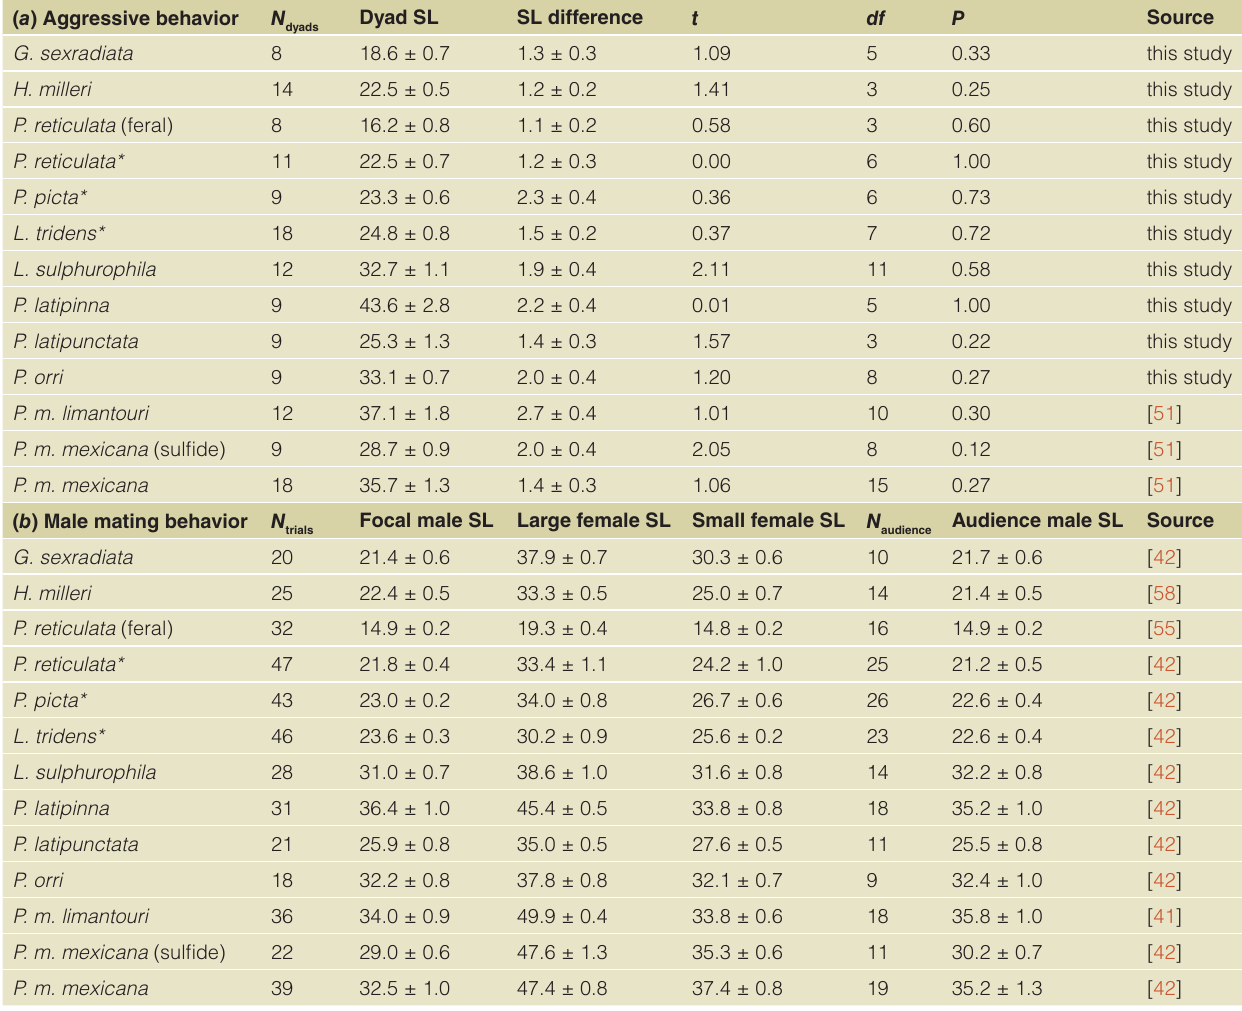
Table 1. The mean (± SE) standard length (SL [mm]) of the test fish used in the experiments examining ( a ) male aggressiveness and ( b ) male sexual behavior and mate choice. In ( a ) SL differences between the two opponents are given along with the results from paired t -tests comparing winner and loser SL after dominance was established. In ( b ) N indicates the number of trials with an audience audience presented during the second part. * indicates species imported by “ Aquarium Dietzenbach GmbH